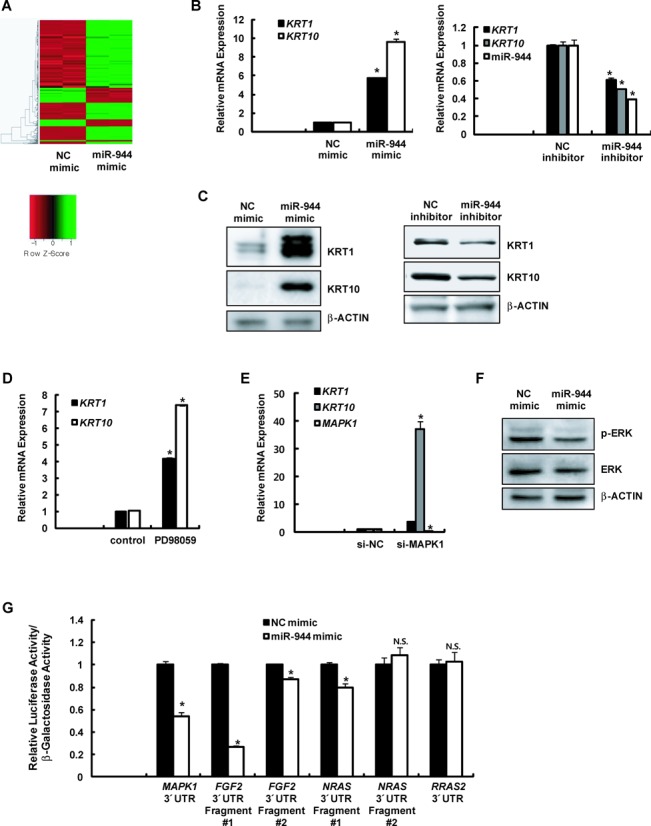
miR-944 modulates keratinocyte differentiation. (A) Heat maps of the mRNAs differentially expressed between negative control mimic (NC mimic)- and miR-944 mimic-transfected keratinocytes. (B) The mRNA expression levels of early differentiation markers (KRT1 and KRT10) in keratinocytes that had been transfected with 20 nM miR-944 mimic or NC mimic (left panel) or with 50 nM miR-944 inhibitor or negative control inhibitor (NC inhibitor; right panel) were analyzed using RT-qPCR. Expression levels were normalized to RPLP0 mRNA expression. Data represent the means ± SD of triplicate biological samples and are representative of three different experiments. *P < 0.05 versus NC mimic or NC inhibitor, unpaired Student's t-test. (C) The protein expression levels of KRT1, KRT10, and β-actin were examined through western blotting after keratinocytes had been transfected with a miR-944 mimic (left panel) or a miR-944 inhibitor (right panel). (D) The mRNA expression levels of KRT1 and KRT10 in keratinocytes that had been treated with PD98049 for 2 days were analyzed using RT-qPCR. Expression levels were normalized to those of RPLP0 mRNA. Data represent the means ± SD of triplicate biological samples and are representative of three different experiments. *P < 0.05 versus control, unpaired Student's t-test. (E) Keratinocytes were transfected with 50 nM siRNA against MAPK1 mRNA (si-MAPK1) or negative control siRNA (si-NC). After 2 days of incubation, RNAs were extracted, and the expression levels of the indicated genes were analyzed using quantitative real-time PCR (RT-qPCR). Data represent the means ± SD of triplicate biological samples and are representative of three different experiments. *P < 0.05 versus si-NC, unpaired Student's t-test. (F) The protein expression levels of phospho-ERK, ERK, and β-actin were examined using western blotting after keratinocytes were transfected with a miR-944 mimic. (G) The MAPK1, FGF2, NRAS, and RRAS2 3’-UTR reporter vector was transfected into WM266-4 melanoma cells that had been previously transfected with a miR-944 mimic. The luciferase and β-galactosidase activities were measured after 24 h. The luciferase activities were normalized to the β-galactosidase activities. Data represent the means ± SD of triplicate biological samples and are representative of three different experiments. *P < 0.05 versus NC mimic, unpaired Student's t-test. (H) The mRNA expression levels of MAPK1, FGF2, NRAS, and RRAS2 in keratinocytes that had been transfected with 20 nM miR-944 mimic or NC mimic (left panel) were analyzed using RT-qPCR. Expression levels were normalized to RPLP0 mRNA expression. Data represent the means ± SD of triplicate biological samples and are representative of three different experiments. *P < 0.05 versus NC mimic, unpaired Student's t-test. (I) The protein expression levels of FGF2, NRAS, and β-actin were examined using western blotting after keratinocytes were transfected with a miR-944 mimic. (J) The protein expression levels of p53, and β-actin were examined using western blotting after keratinocytes were transfected with a miR-944 mimic.